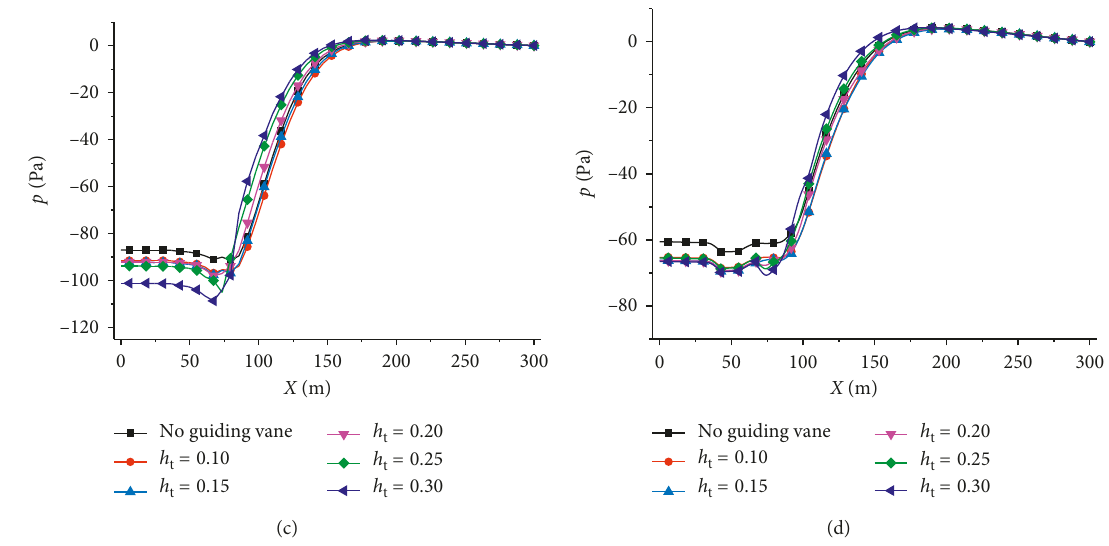
Figure 8: Static pressure profiles at different positions at X -axis. (a) α � 4 ° , u � 1m/s. (b) α � 4 ° , u � 3m/s. (c) α � 10 ° , u � 1m/s. (d) α � 10 ° , u � 3